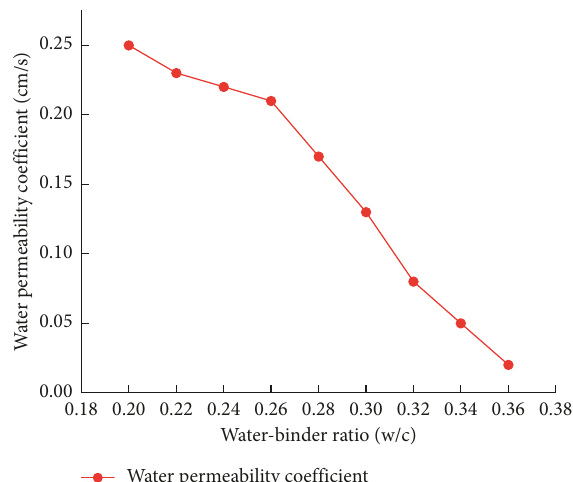
Figure 9: Relationship between water-binder ratio and water permeability